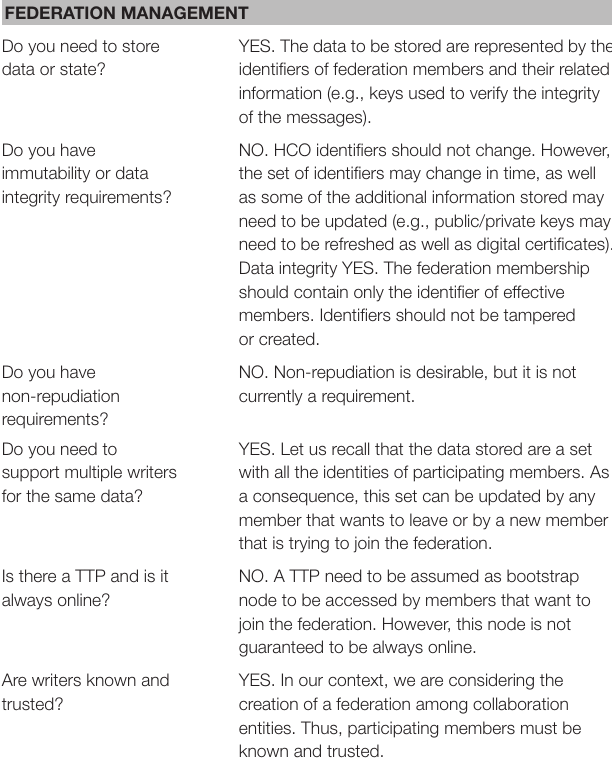
TABLE 2 | Assessment of blockchain in the federation management.